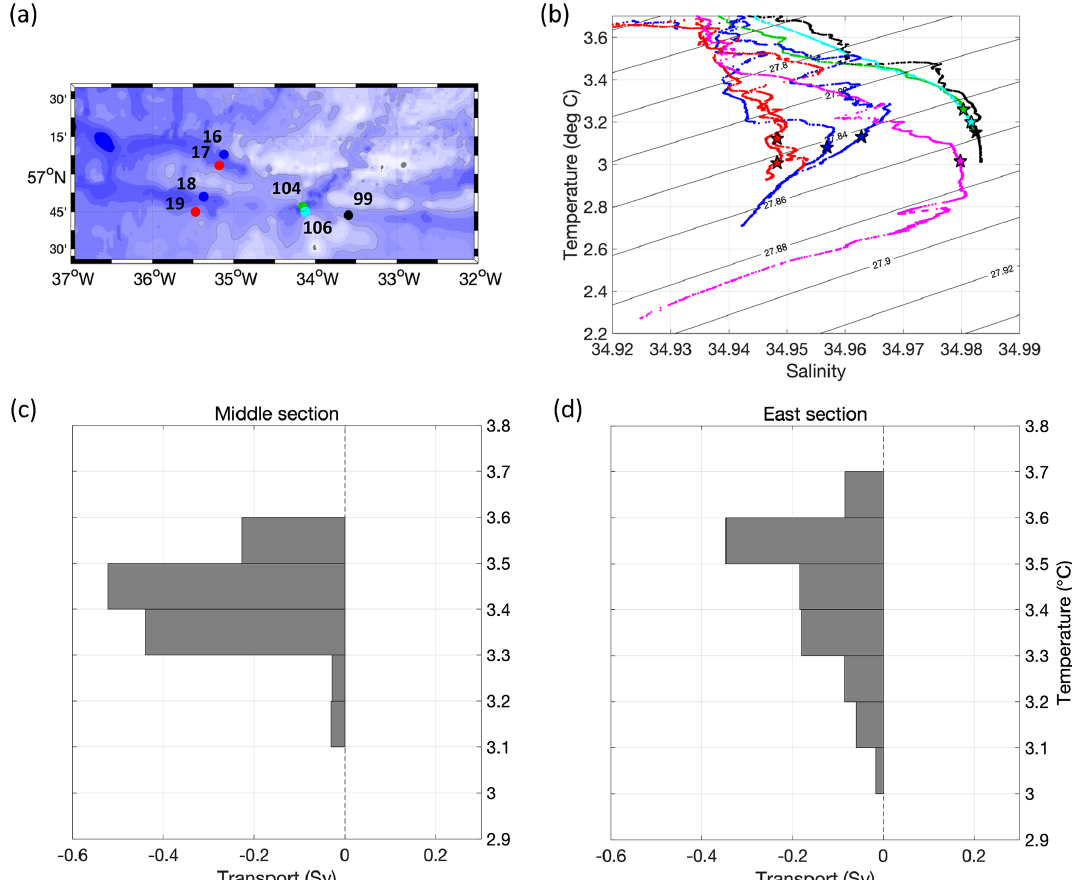
Figure 4. (a, b) θ – S diagram of ISOW localized at the entrance of the BFZ (station 99 at the East section), in the rift valley (stations 104 and 106 at the Middle section) and at the exit of the BFZ (West section) for RREX15. At the West section, the northern stations of each channel are in blue (stations 16 and 18), and the southern stations are in red (stations 17 and 19). Purple dots indicate the θ – S properties of station 122 for RREX2015, which is localized in the westward core of ISOW in the CGFZ, at 52.7 ◦ N, 35.1 ◦ W (Petit et al., 2018). Each station is localized in the ISOW core of the sections. Stars indicate the 2150m isobath for each profile, e.g., the bottom depth of the eastern sill. (c, d) Transports (Sv) cumulated in temperature bins of 0.1 ◦ C and averaged at the (d) East and (c) Middle sections in